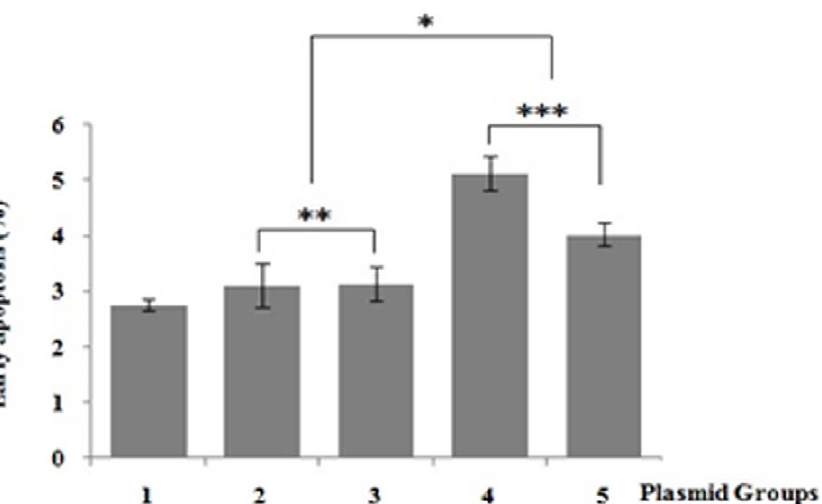
Figure 5. Early apoptosis rate in HEK293 cells. Plasmid Groups: 1. pcDNA3.1-myc-His(-)B; 2. pcDNA3.1-myc-His(-)B-ataxin-3-20Q; 3. pcDNA3.1- myc-His(-)B-ataxin-3-20Q K166R ; 4. pcDNA3.1-myc-His(-)B-ataxin-3-68Q; 5. pcDNA3.1-myc-His(-)B-ataxin-3-68Q K166R . Statistical significance was assessed with a one-way ANOVA: 2 and 4: P , 0.05 (*); 2 and 3 P . 0.05 (**); 4 and 5: P , 0.05 (***).